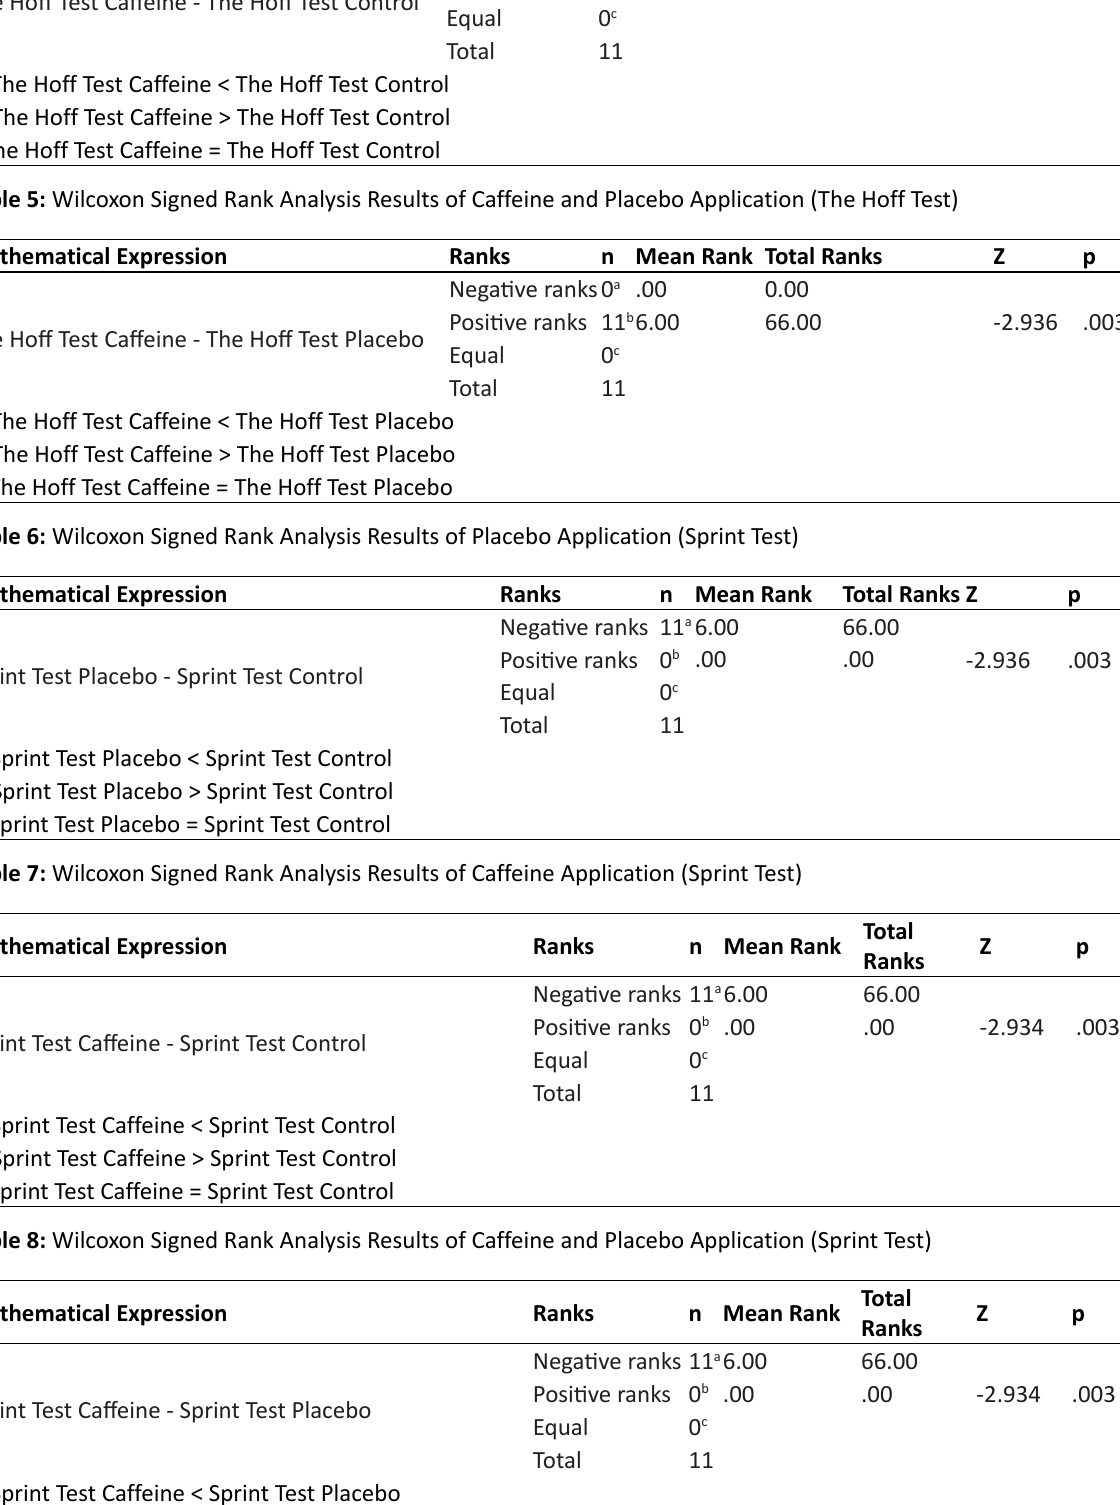
Table 4: Wilcoxon Signed Rank Analysis Results of Caffeine Application (The Hoff Test) Mathematical Expression